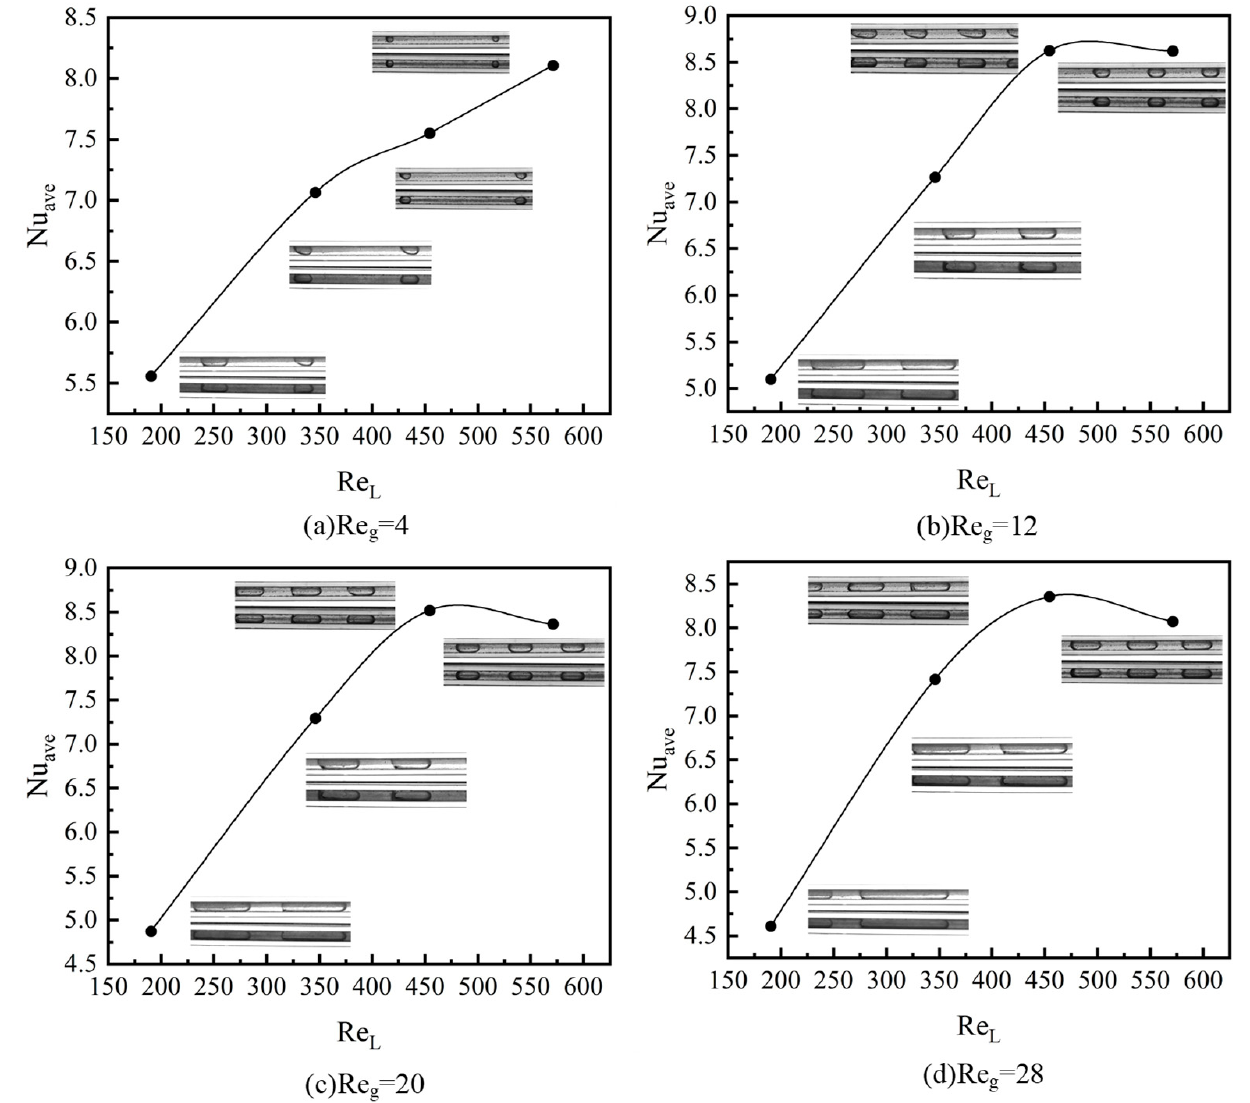
Figure 7. Effect of liquid phase Reynolds number on heat transfer in square tube.